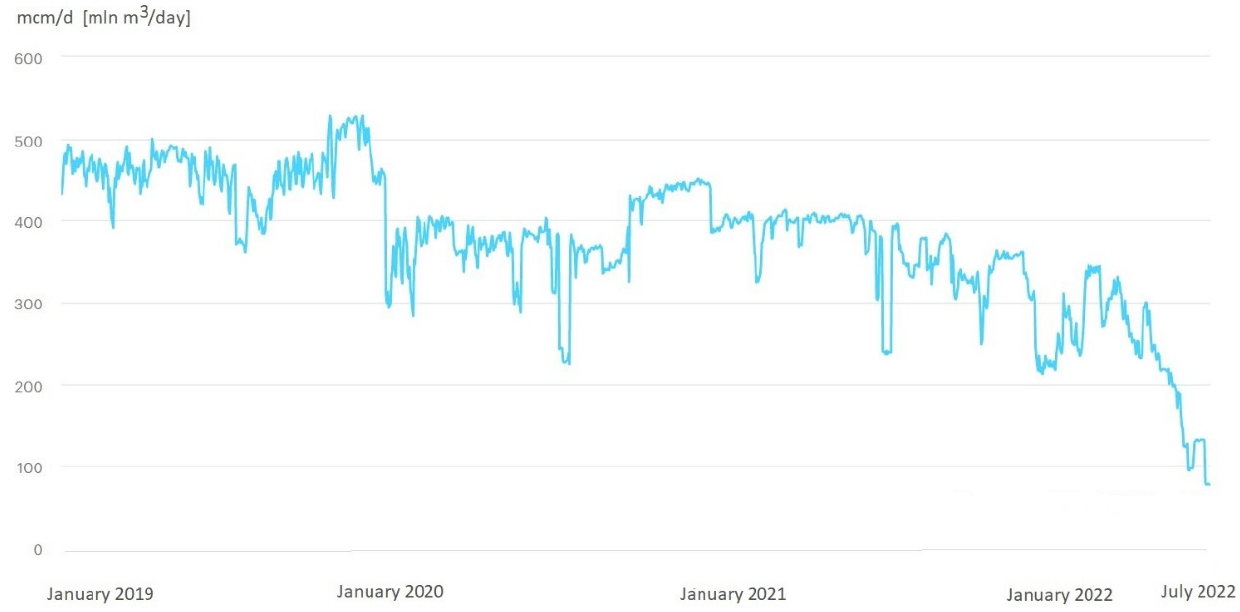
Figure 5. Russian natural gas flow to the European Union, January 2019–July 2022. Source: IEA, Russian natural gas flow to the European Union, January 2019–July 2022 , IEA, Paris [63].